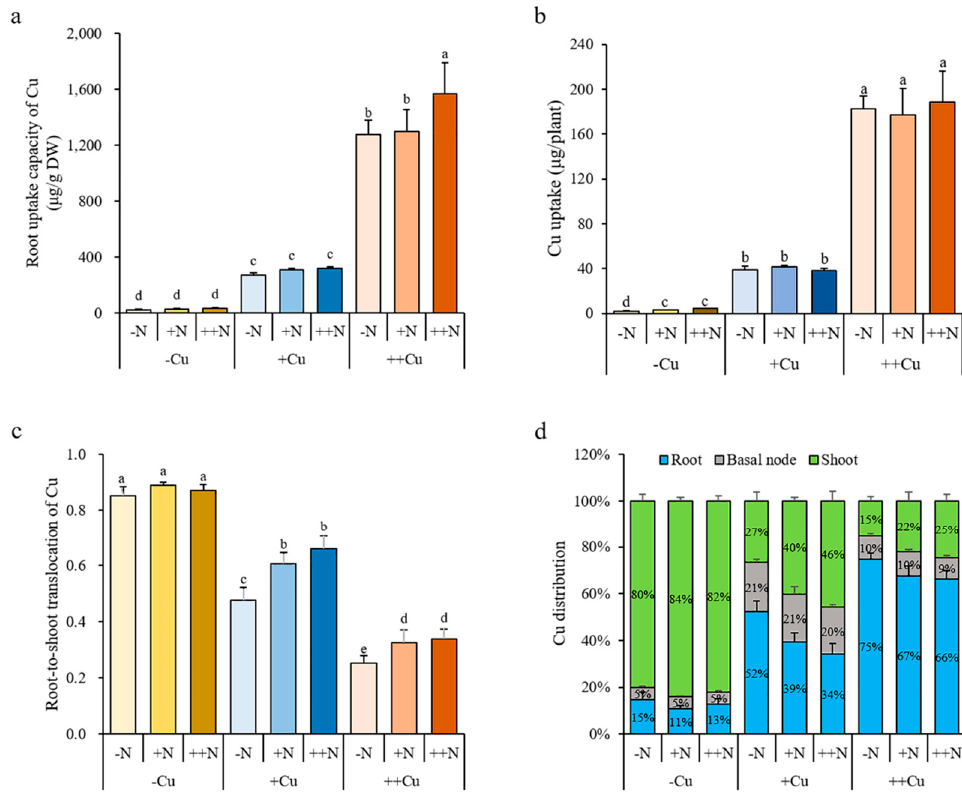
Figure 5. Root uptake capacity of Cu ( a ), Cu uptake in whole plant ( b ), root-to-shoot translocation of Cu ( c ), and Cu distribution ( d ) of rice plant grown in solutions with different combinations of Cu (-Cu, 0 μ M; +Cu, 0.15 μ M; ++Cu, 1.5 μ M) and N (-N, 0.288 mM; +N, 2.88 mM; ++N, 14.4 mM) supply for three weeks. The Cu uptake was calculated as the Cu accumulation of whole plant; the uptake capacity of Cu was calculated as the Cu accumulation of whole plant / root dry weight; the root-to-shoot translocation of Cu was calculated as the Cu accumulation in shoot / the Cu accumulation of whole plant; the Cu distribution in each organ was calculated as the Cu accumulation in each organ / the Cu accumulation of whole plant. Data are means ±SD of three biological replicates. Different letters indicate significant difference at p < 0.05 by Tukey’s test.